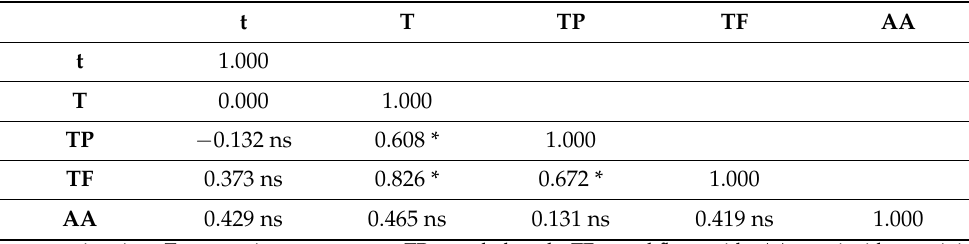
Table 4. Correlation matrix for the relationship for extraction process variables and detected analytes of the